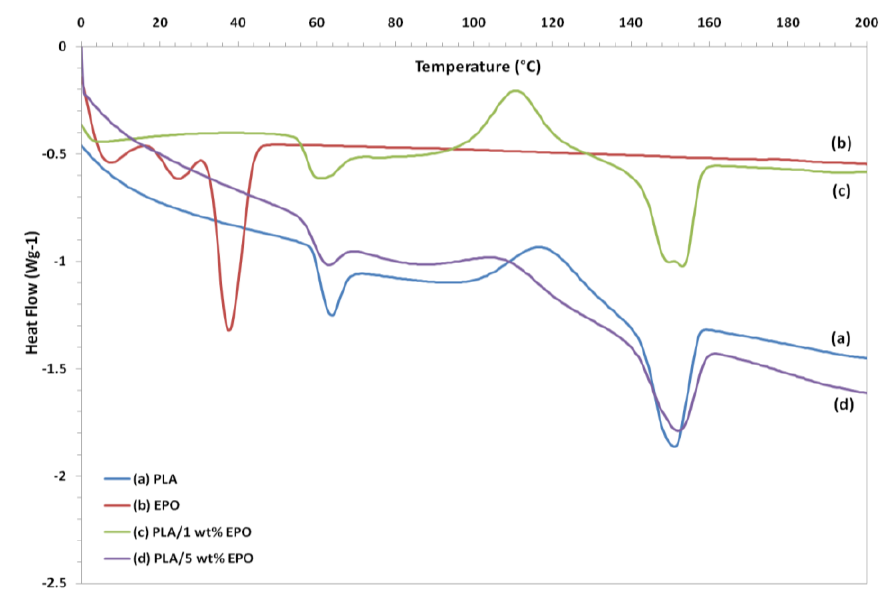
Figure 13. DSC thermograms of neat PLA and PLA/EPO